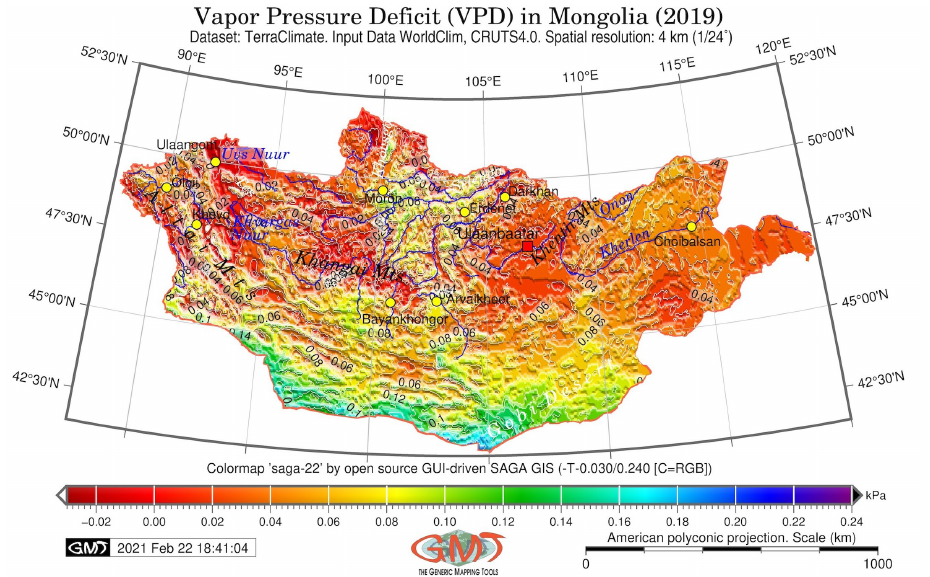
Figure 8. Vapor pressure deficit in Mongolia in 2019. Mapping: GMT by script available in Appendix B.7. Source: